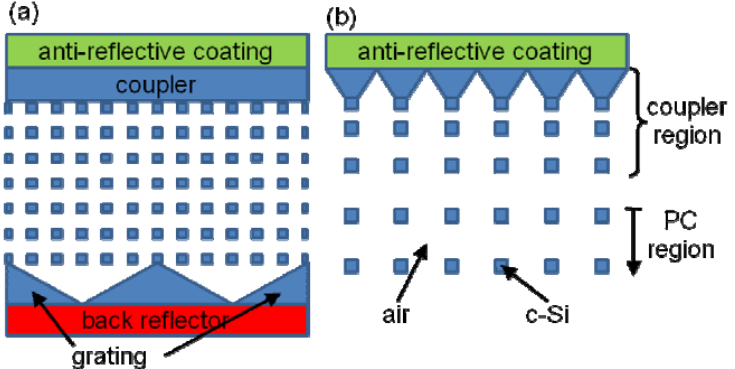
Figure 4. Schematics for PC SCs showing (a) the entire structure and (b) the front coupler region. (Reused with permission from [25]. © 2009, Optical Society of